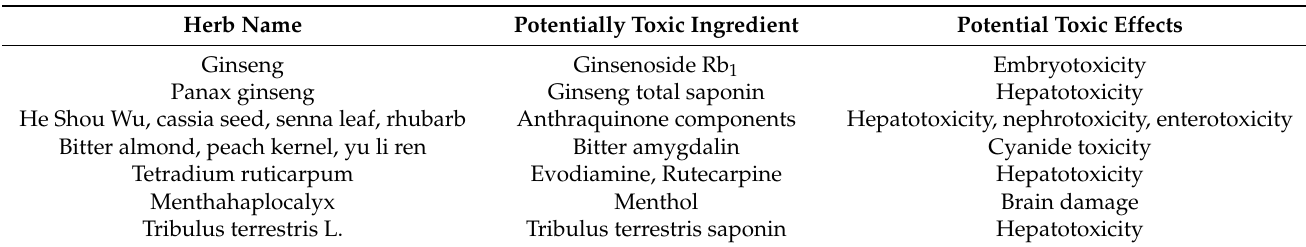
Table 3. Potentially toxic components and toxic effects of biological